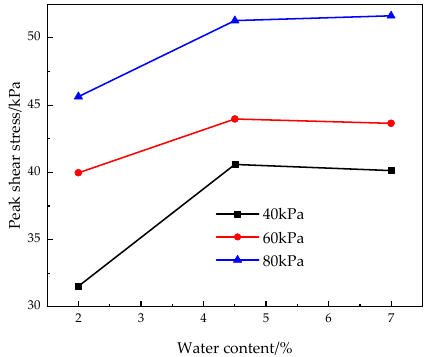
Figure 13. The influence of water content on the peak shear stress of the reinforced soil interface under the freezing state ( − 5 °C).